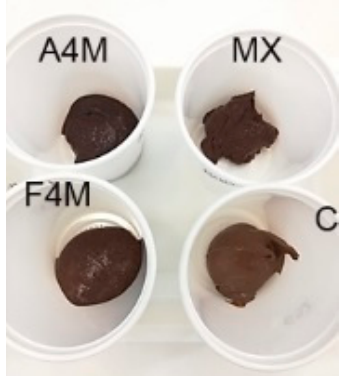
Figure 1. Appearance of formulated cellulose ethers spreads compared to a commercial control (A4M: methycellulose Methocel A4M; MX: methycellulose Methocel MX; F4M: hydroxypropylmethycellulose Methocel F4M; C: commercial cocoa spread).